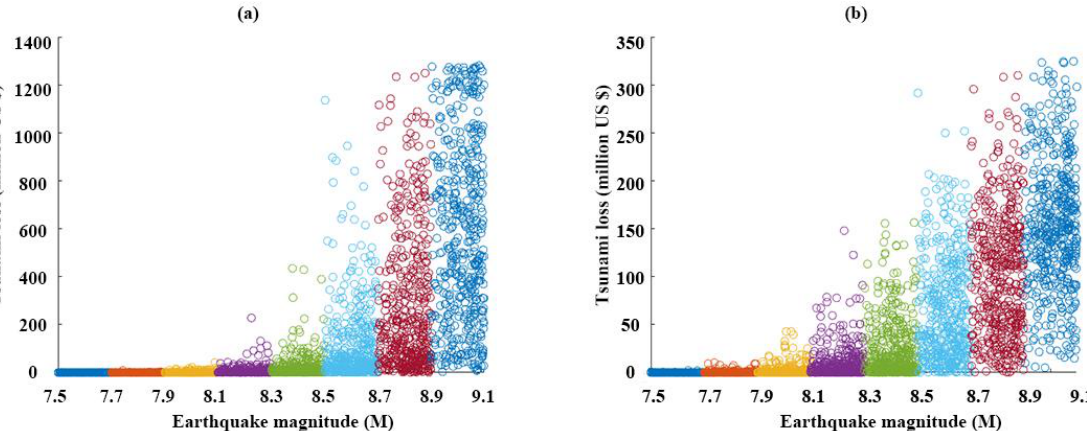
Figure 5. Tsunami loss plot for ( a ) Iwanuma and ( b ) Onagawa. The tsunami loss was estimated using a currency conversion rate of USD 1 = JPY 100.